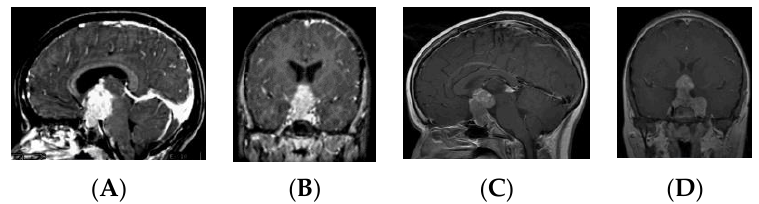
Figure 3. Type II. Post-contrast MR, sagittal ( A ) and coronal ( B ) views of a patient with S-GCT. Note the third ventricle tumor extension into the sella turcica. Post-contrast MR, sagittal ( C ) and coronal ( D ) views of a patient with S-GCT demonstrate further lateral extension to the cavernous sinus. Figure 4. Type III. Post-contrast MR, sagittal ( A ) and coronal ( B ) views of a patient with S-GCT. Note the tumor from the floor of the third ventricle to the sella turcica. Post-contrast MR, sagittal ( C ) and coronal ( D ) views of a patient with S-GCT. Note the tumor from the floor of the third ventricle to sella turcica with further extension into the cavernous sinus.